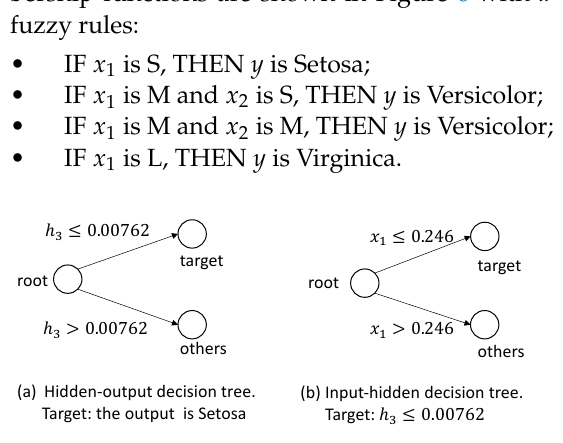
Figure 14. The decision trees for the target Setosa.